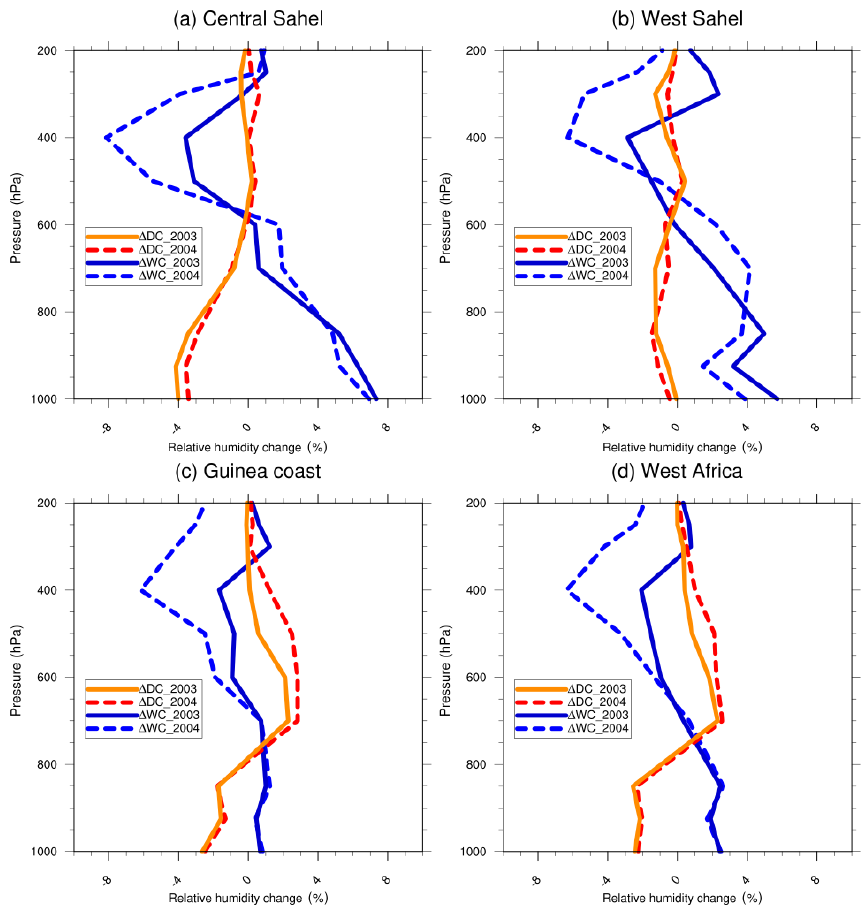
Figure 8. Vertical profile changes in relative humidity for JJAS 2003 and JJAS 2004 from the dry ( (cid:49) DC) and wet ( (cid:49) WC) experiments with respect to the corresponding control experiment over the (a) Central Sahel, (b) West Sahel, (c) Guinea coast and (d) West Africa. Table 3. The pattern correlation coefficient (PCC) and the mean bias (MB) values for the JJAS 2m temperature for model simulations with respect to CRU, calculated for the Guinea coast, Central Sahel, West Sahel and entire West Africa domains during the JJAS 2003 and JJAS 2004 periods. Central Sahel West Sahel Guinea West Africa PCC MB PCC MB PCC MB PCC MB ( ◦ C) ( ◦ C) ( ◦ C) ( ◦